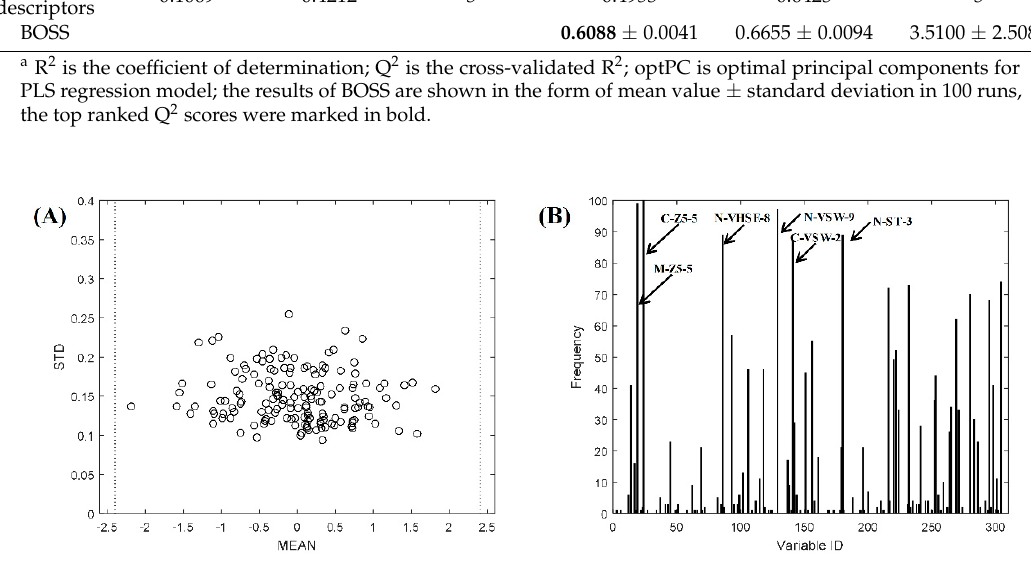
Figure 3. The result of QSAR model building on the FRAP dataset. ( A ) The result of MPA-based outlier detection on the FRAP dataset of integrated descriptors. No outlier was detected. ( B ) Frequency of variables selected by the BOSS method on the FRAP dataset in 100 runs. The higher frequency denotes higher variable importance. The six top variables with frequency larger than 75 are marked in the figure.